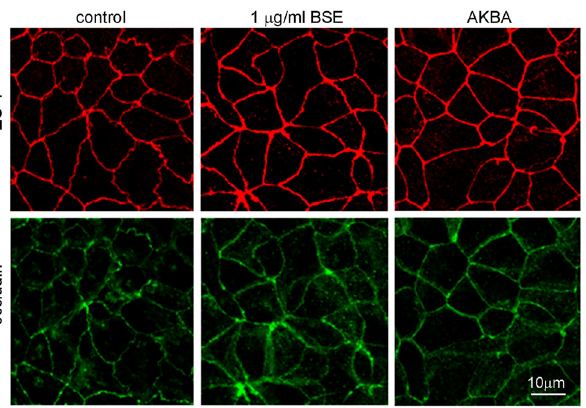
(green). Images were collected by confocal laser-scanning microscope and are representative of 3 independent experiments. Scale bar = 10 μ m.